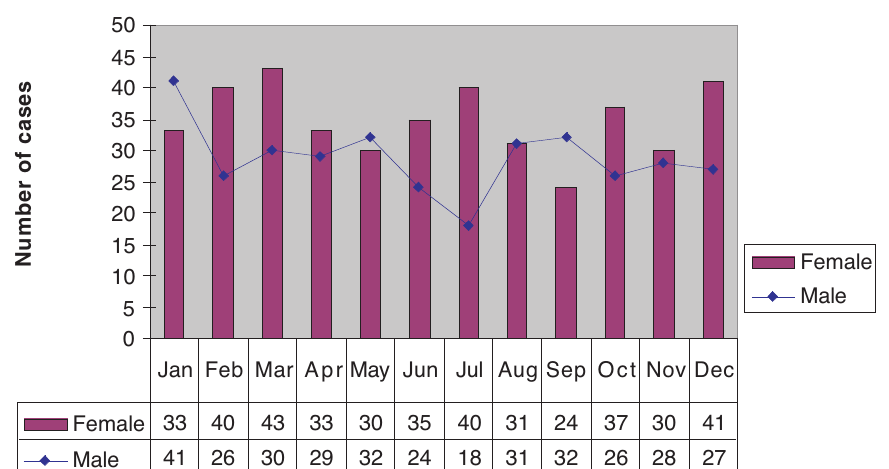
Figure 1 The distribution of all SAH cases according to sex and months (p = 0.105; p